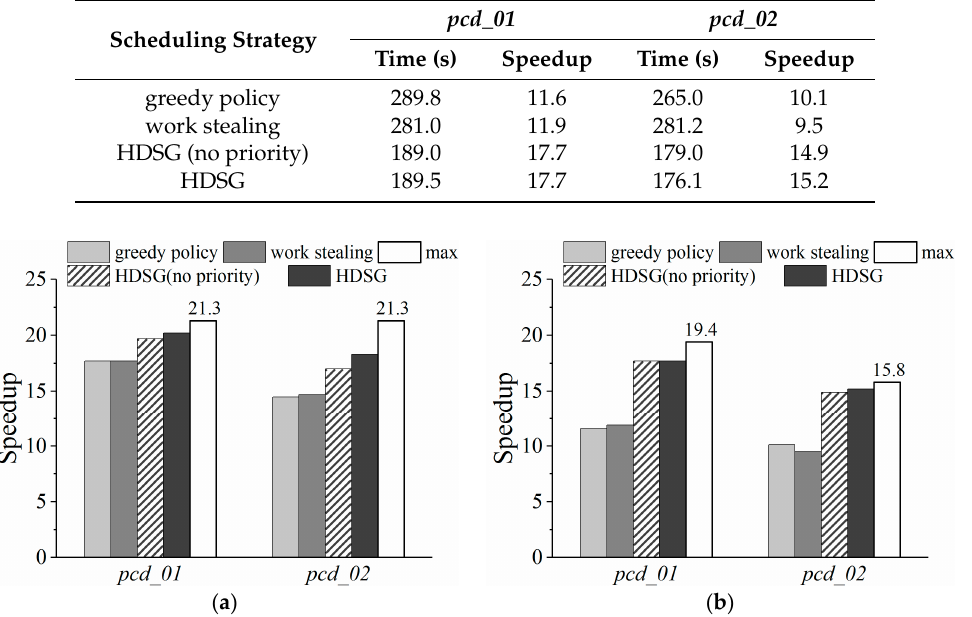
Figure 12. Speedups of the hybrid parallel algorithm with different scheduling strategies. ( a ) hpc_01; ( b ) hpc_02.